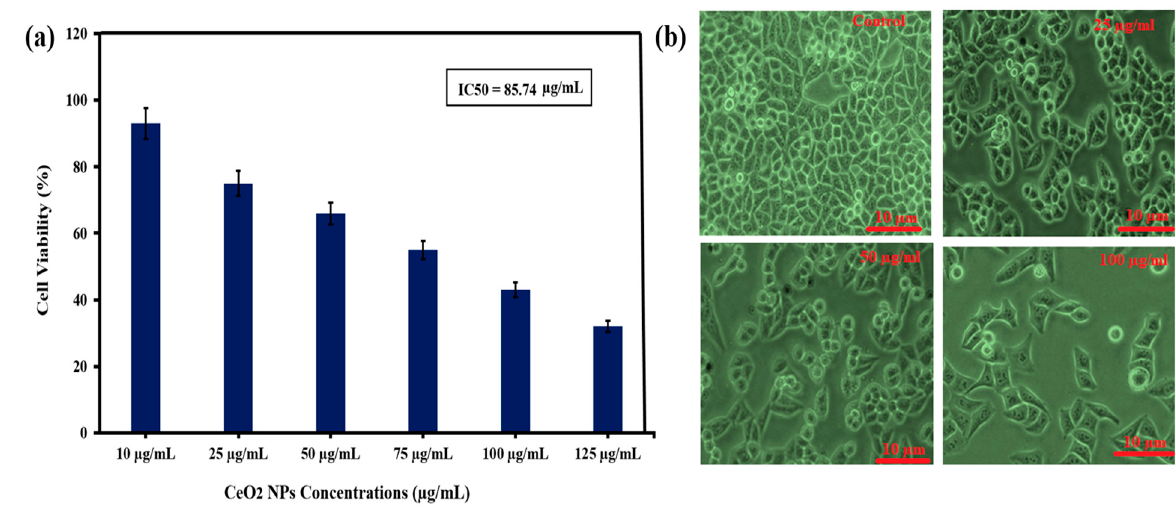
Figure 5. ( a ) Cell viability (%) of CeO 2 treated HeLa cells after 24 h, (t-test). ( b ) Effect of green synthesized CeO 2 NPs on HeLa cells at different doses (25, 75, and 100 µg/mL) and untreated cells (control).